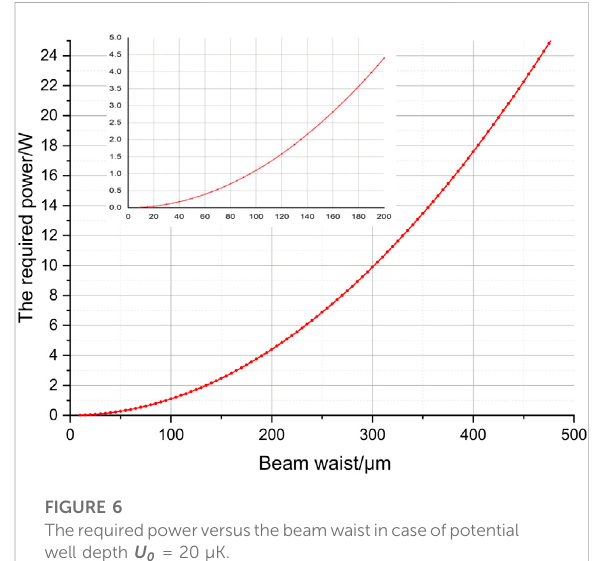
FIGURE 7 The number of trapped cold atom versus the beam waist of the optical